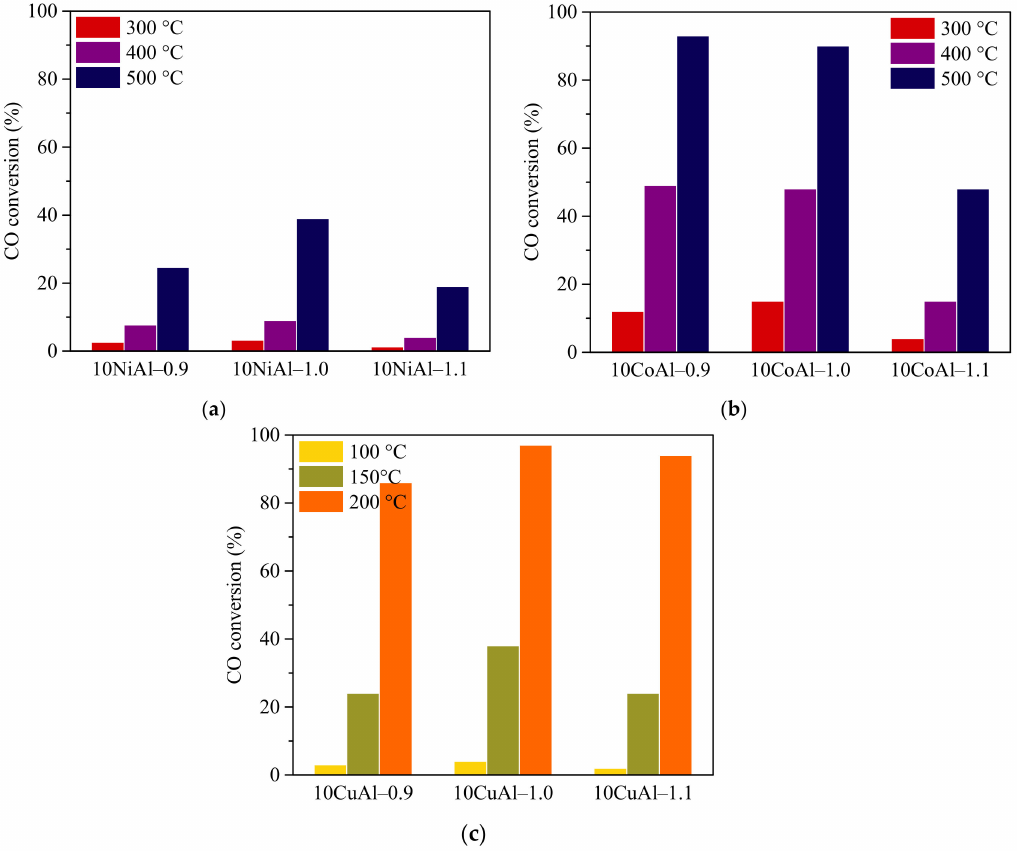
Figure 7. ( a , b , c ) CO conversion under steady state conditions over the 10MAl − x calcined catalysts. Table 4. E ff ect of RV / OV ratio on the light-o ff , T 50 and T 100 temperatures of the 10MAl − x catalyst samples. Sample T